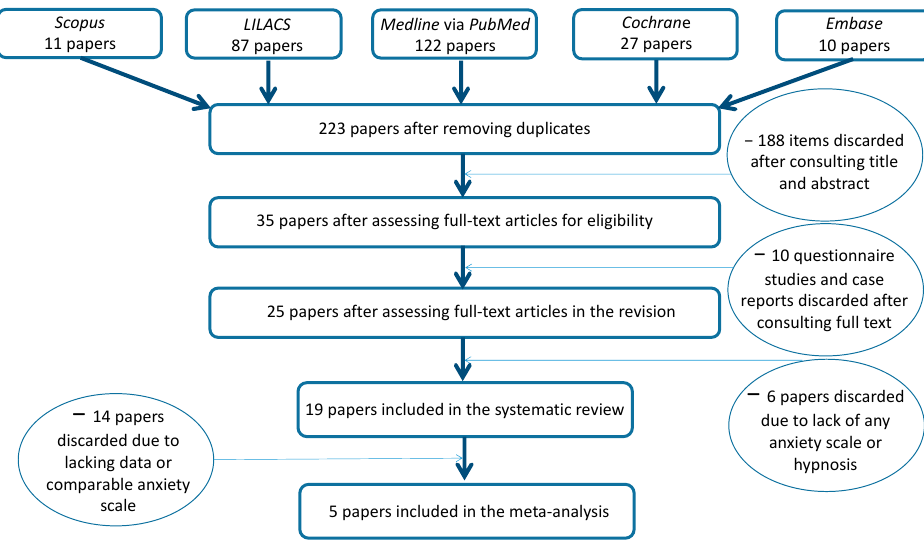
Figure 1. Flowchart of the